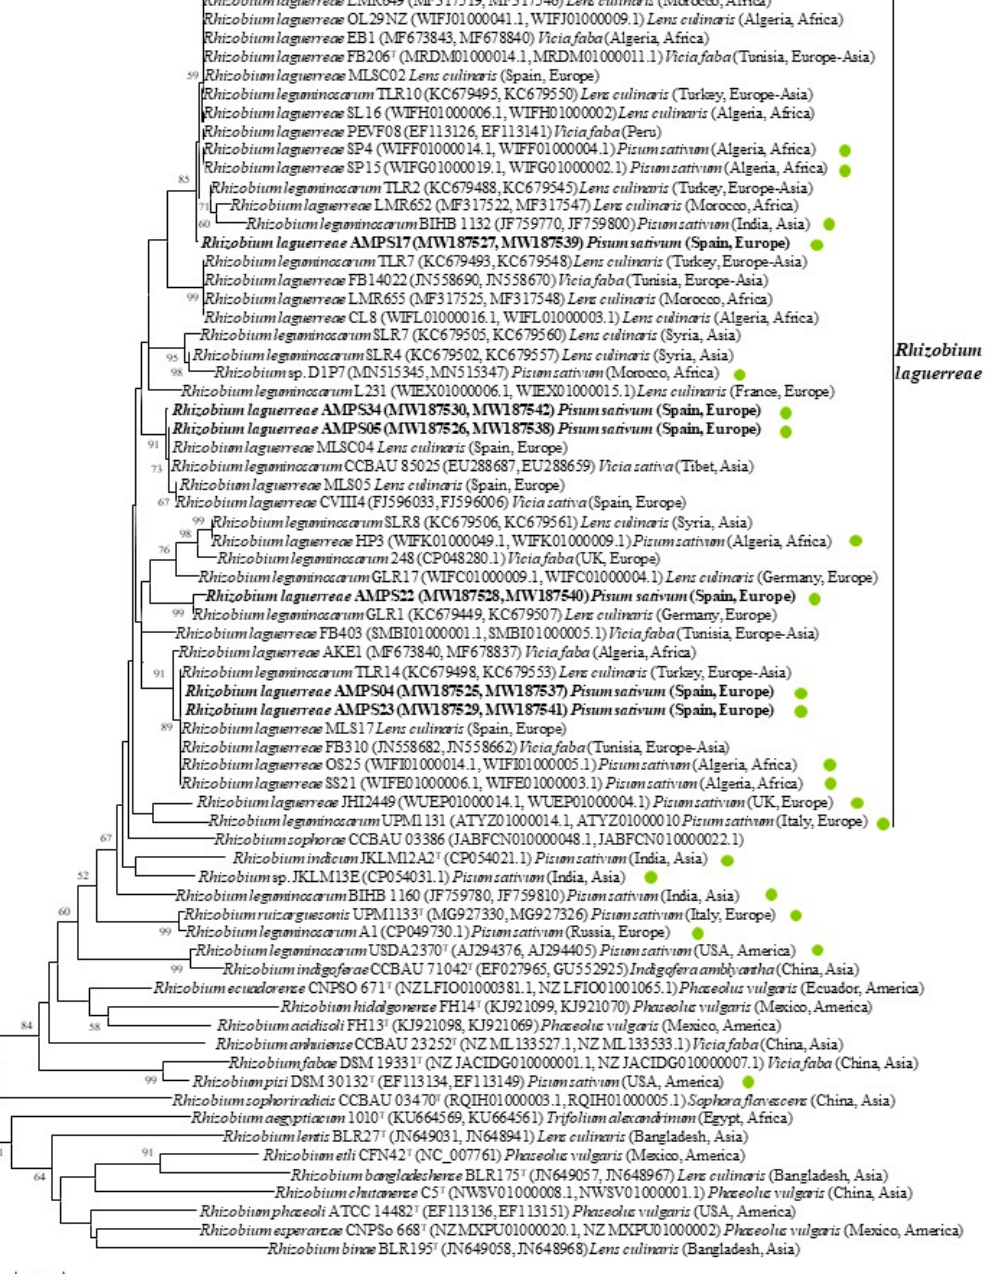
Figure 3. Neighbor-joining unrooted phylogenetic tree based on recA and atpD concatenated gene sequences (728 nt) showing the position of representative strains from each group within genus Rhizobium . Bootstrap values calculated for 1000 replications are indicated. Bar: 1 nt substitution per 100 nt. Filled green circles indicated the strains isolated from Pisum sativum worldwide.